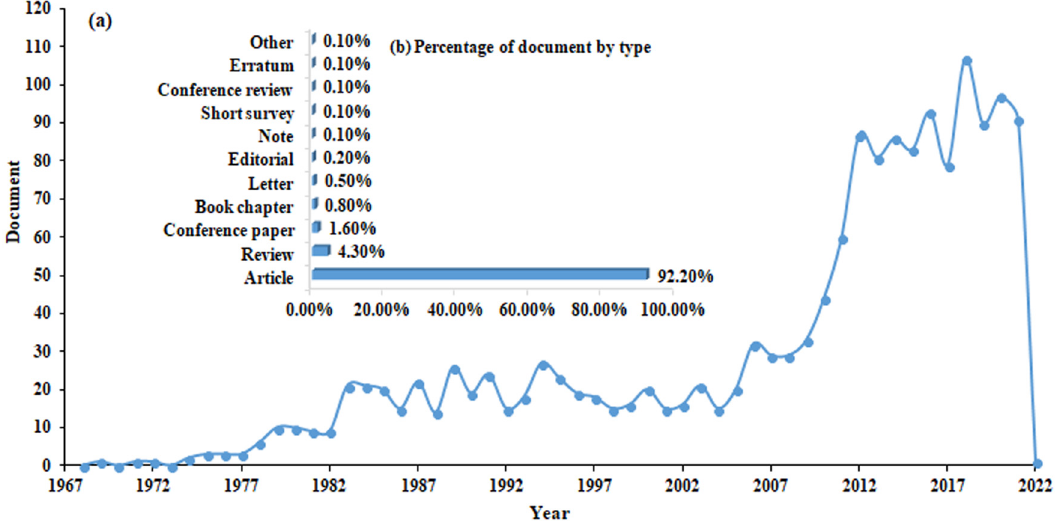
Figure 1: ( a ) The number of documents of ACT degradation by year and ( b ) the percentage of each type of documents. Source: Scopus